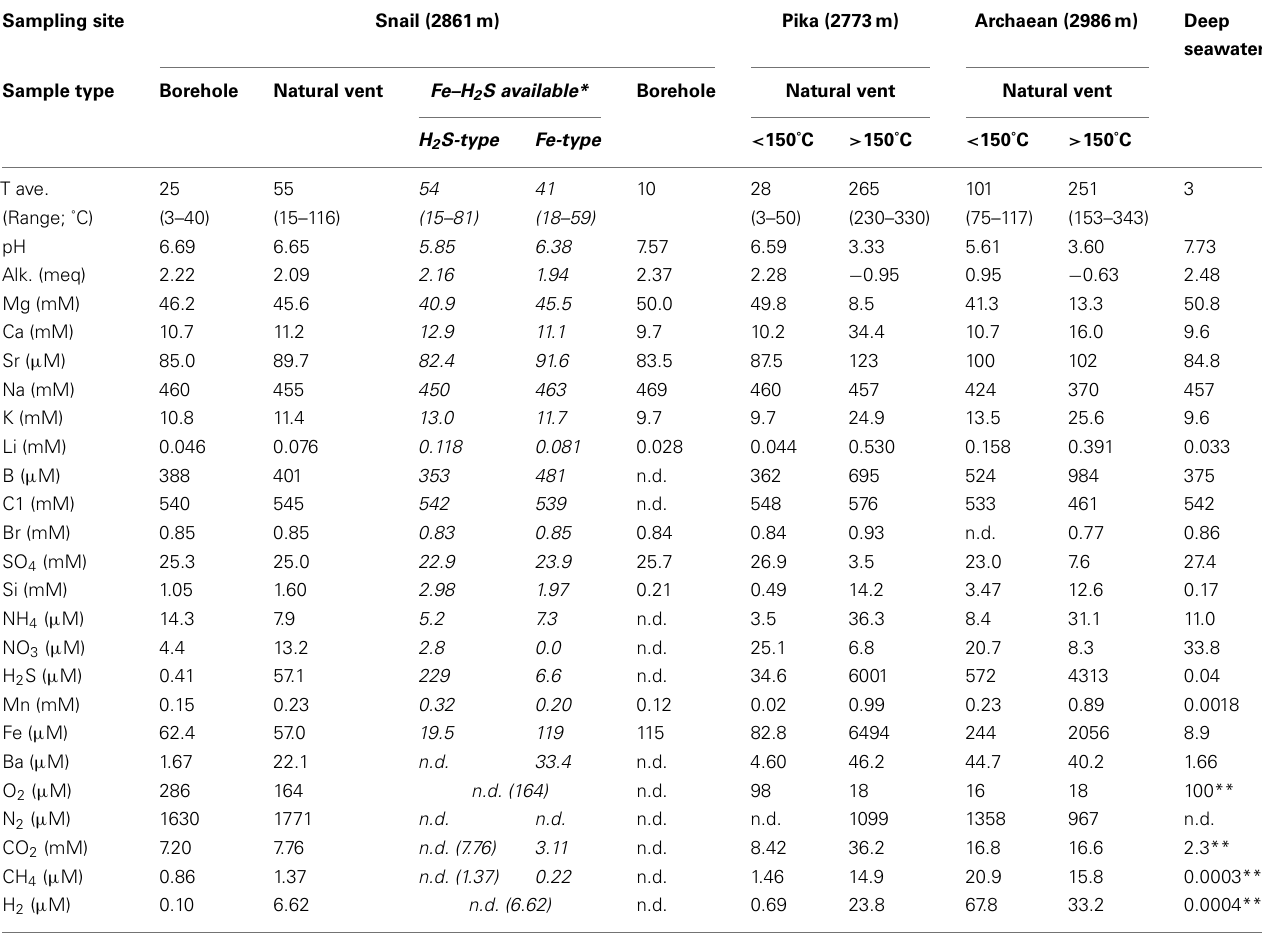
TableA1 | Summary of the geochemical characteristics of fluid samples collected in the